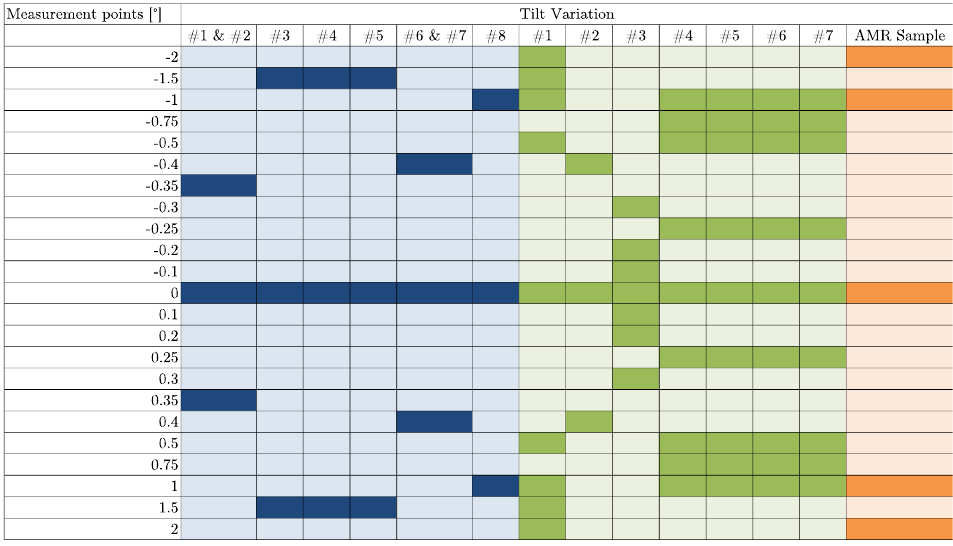
Figure A1. Tilt variation measurement plan for all evaluated sensors; blue, resolvers; green, inductive sensors; orange, AMR sensor.